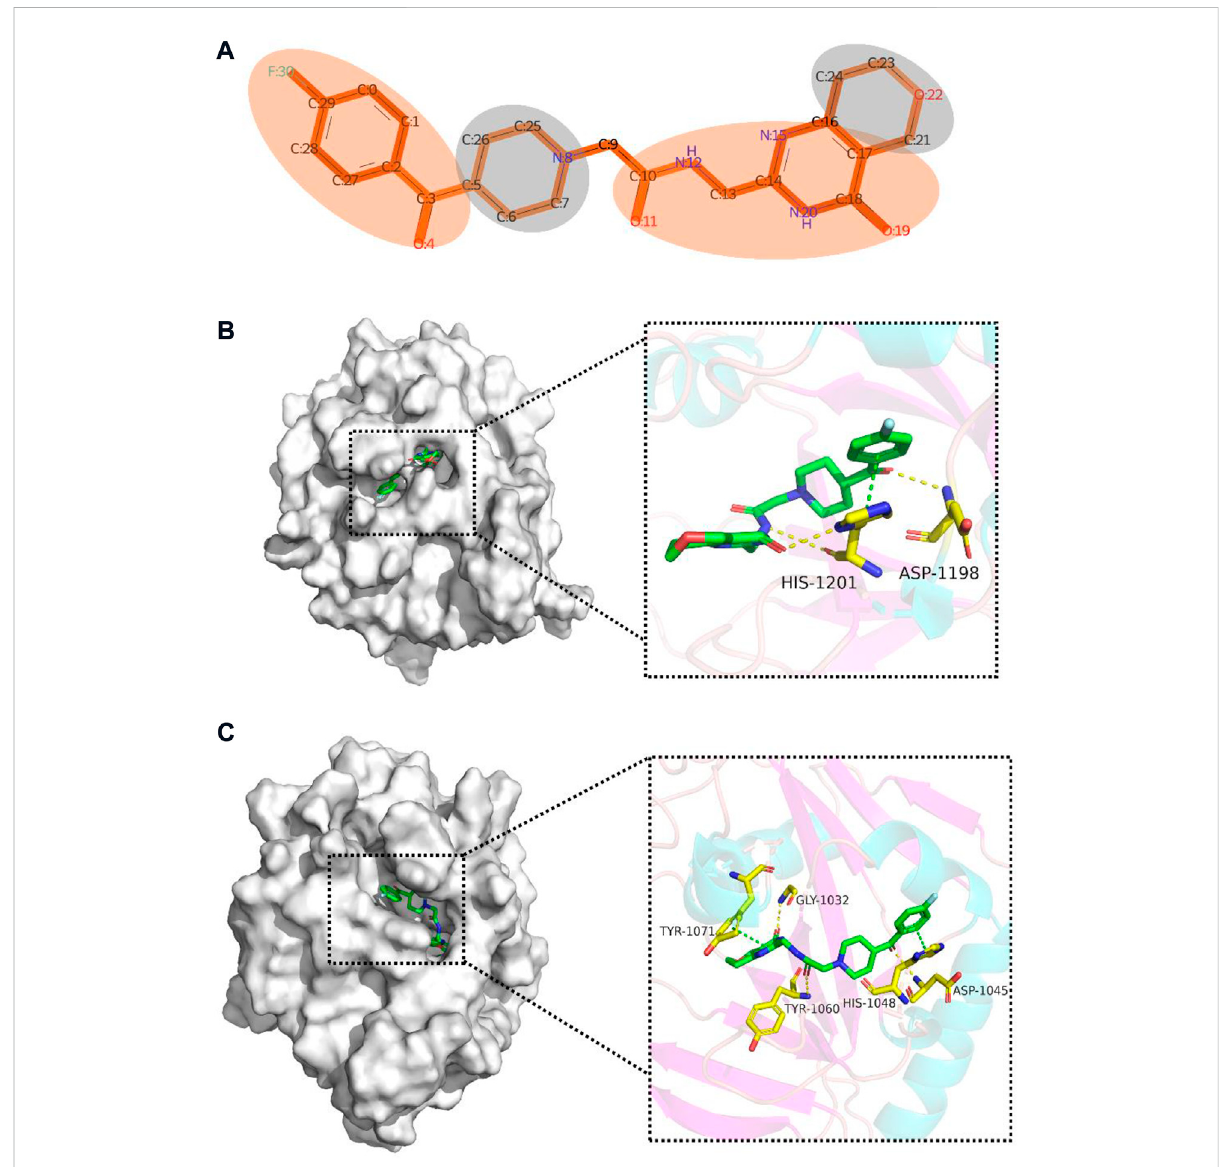
FIGURE 9 Interpretativeanalysis ofthepredictedresults oftheactivecompound(CHEMBL2419697)withhighselectivityforPARP-5AandPARP-5B inthe multi-task FP-GNN model. (A) Mapping the attention coef fi cients to the active molecule through the GNN module in the multi-task FP-GNN architecture to highlight substructures/chemical fragments that contribute signi fi cantly to the predicted outcomes. (B) and (C) represent the predictedbindingmodesofthemoleculetoPARP-5A(PDBID:3UDD)(Glide-XPdockingscore: − 8.004 kcal/mol)andPARP-5B(PDBID:7CE4) (Glide-XP docking score: − 8.602 kcal/mol), respectively. π - π interactions are indicated by green dotted lines, and hydrogen bonds are depicted by yellow dotted lines. The binding modes were predicted using Glide-XP docking and the fi gures were generated using PyMOL software (https:// pymol.org/2/).